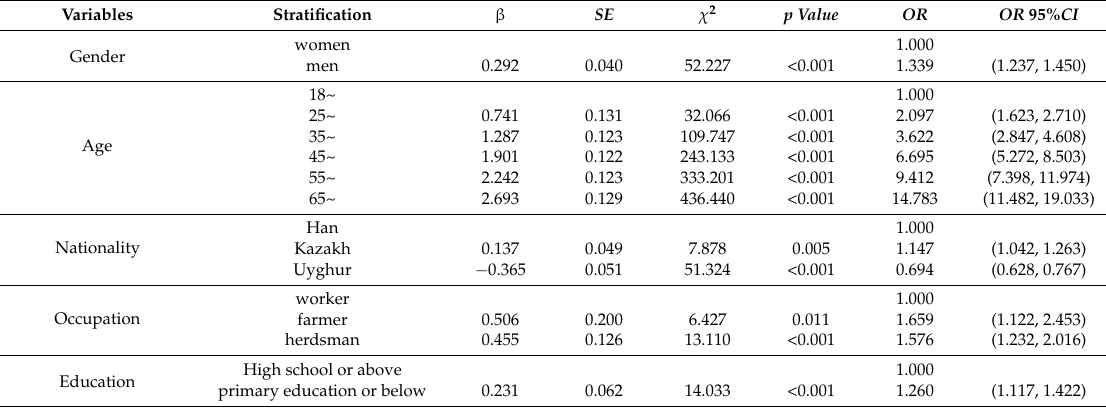
Table 6. Factors associated with the prevalence of hypertension from multivariate logistic